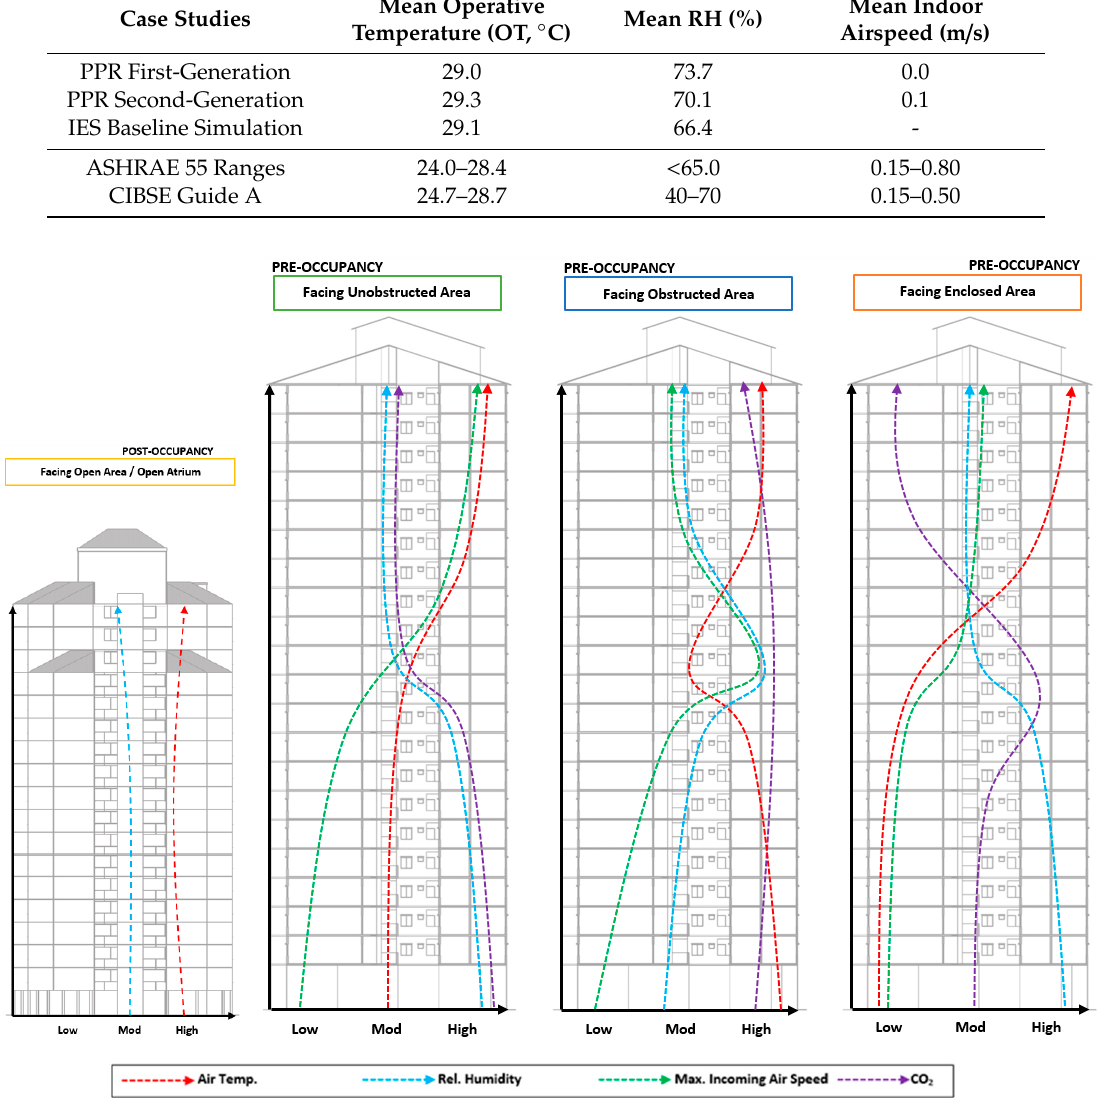
Figure 11. The identified four different environmental conditions zones in the PPR Seri Aman and PPR Beringin.